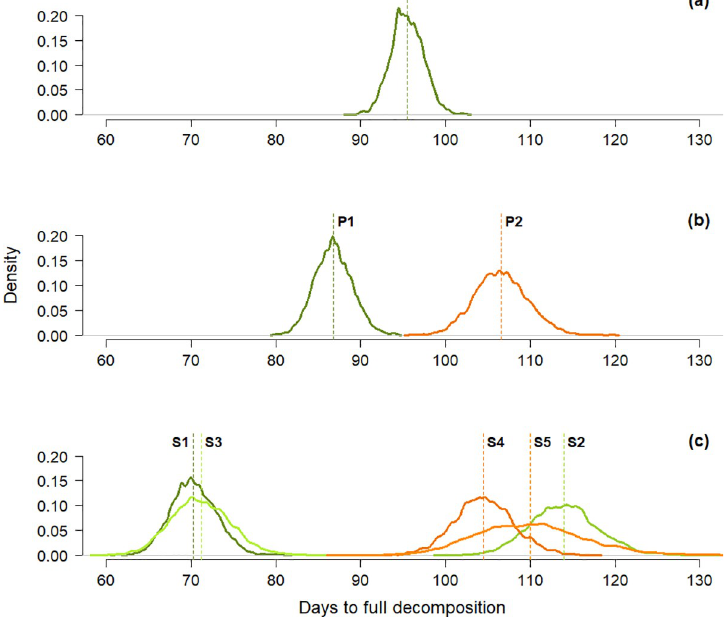
Fig 3. Posterior distribution of estimated mean decomposition time. a) All nests (n = 1,511); b) nests from the first (P1; n = 832; green) and second period (P2; n = 679; orange; c) nests from different surveys from P1 (S1 (n = 278); S2 (n = 305); S3 (n = 249); green curves) and P2 (S4 (n = 450); S5 (n = 229); orange curves). Coloured dashed lines show the mean values of the posterior distributions. Curves with larger breadth indicate higher